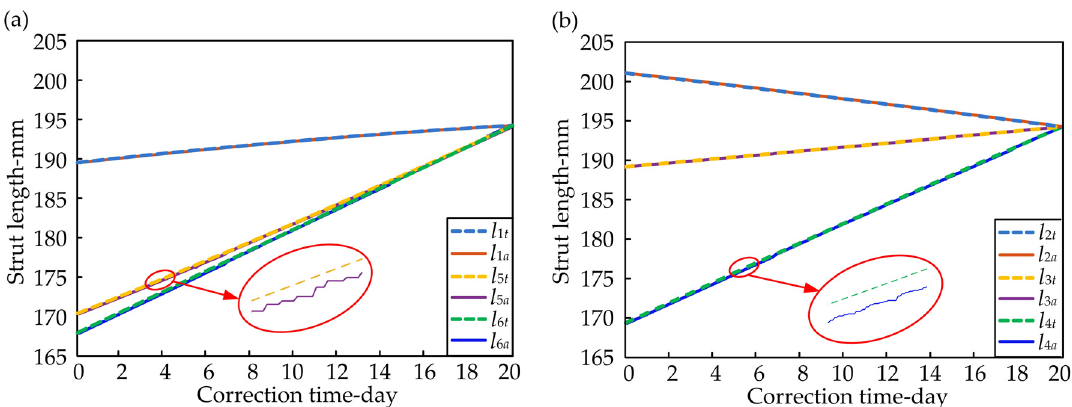
Figure 11. Theoretical ( l it ) and actual ( l ia ) value of rod length during correction with joint adjustment for equal bone distraction. ( a ) Theoretical ( l it ) and actual ( l ia ) values of length of rod 1, rod 5 and rod 6. ( b ) Theoretical ( l it ) and actual ( l ia ) values of length of rod 2, rod 3 and rod 4.